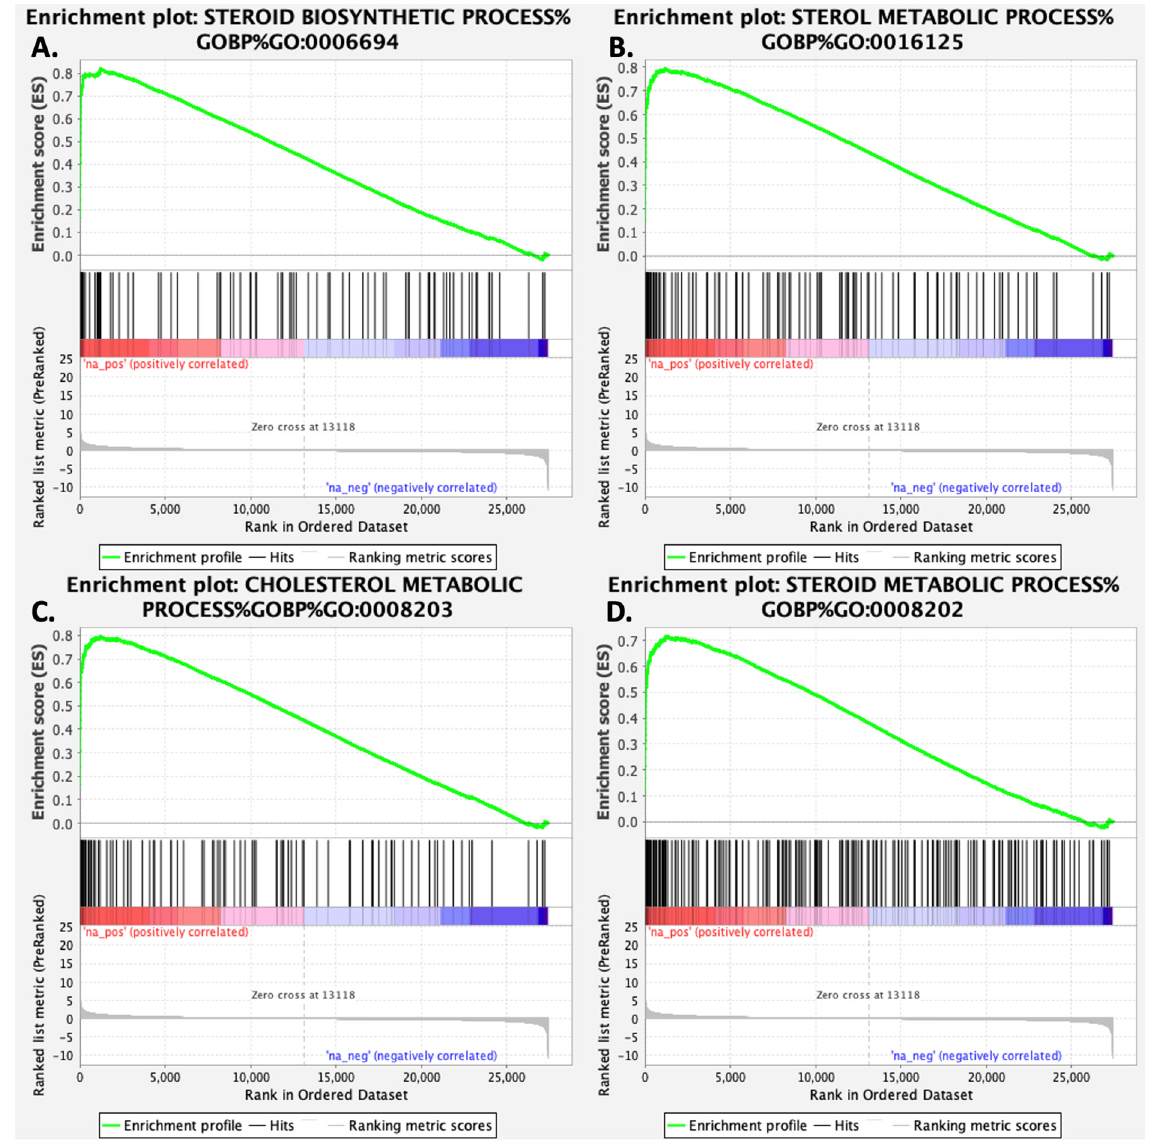
Figure 5. Enrichment plots from gene set enrichment analysis (GSEA) of genes modulated by gigantol in MA-10 Leydig cells. ( A ) Steroid biosynthetic process, ( B ) sterol metabolic process, ( C ) cholesterol metabolic process, and ( D ) steroid metabolic process are important biological processes for Leydig cells’ normal functions.